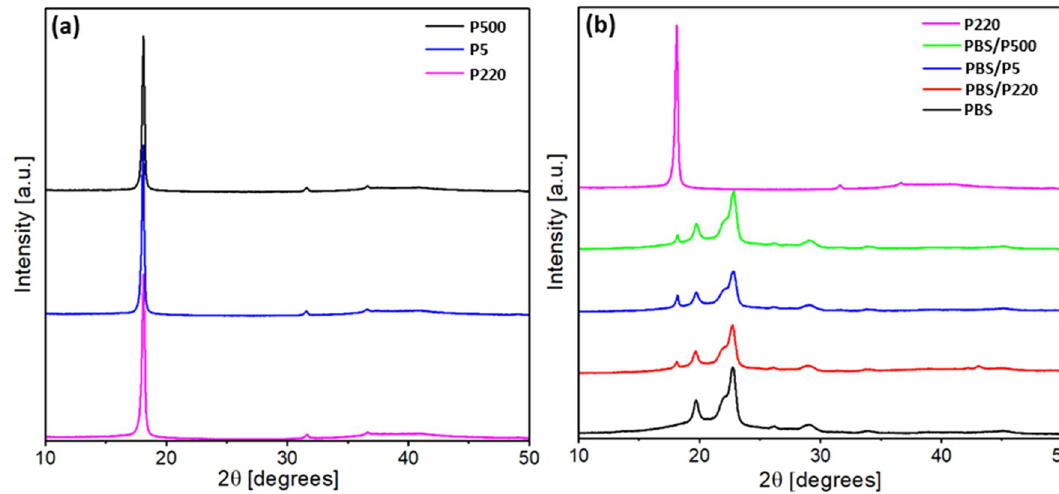
Figure 5. X ‐ ray diffraction patterns of ( a ) PTFE powders ( b ) PBS and PBS/PTFE composites.